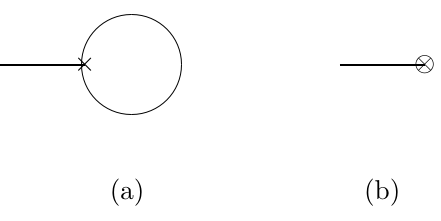
Figure 6 . This figure shows the Feynman diagrams contributing to the annulus amplitude with one external open string. The interaction vertex with a × represents a disk amplitude, while a interaction vertex with ⊗ represents part of an annulus